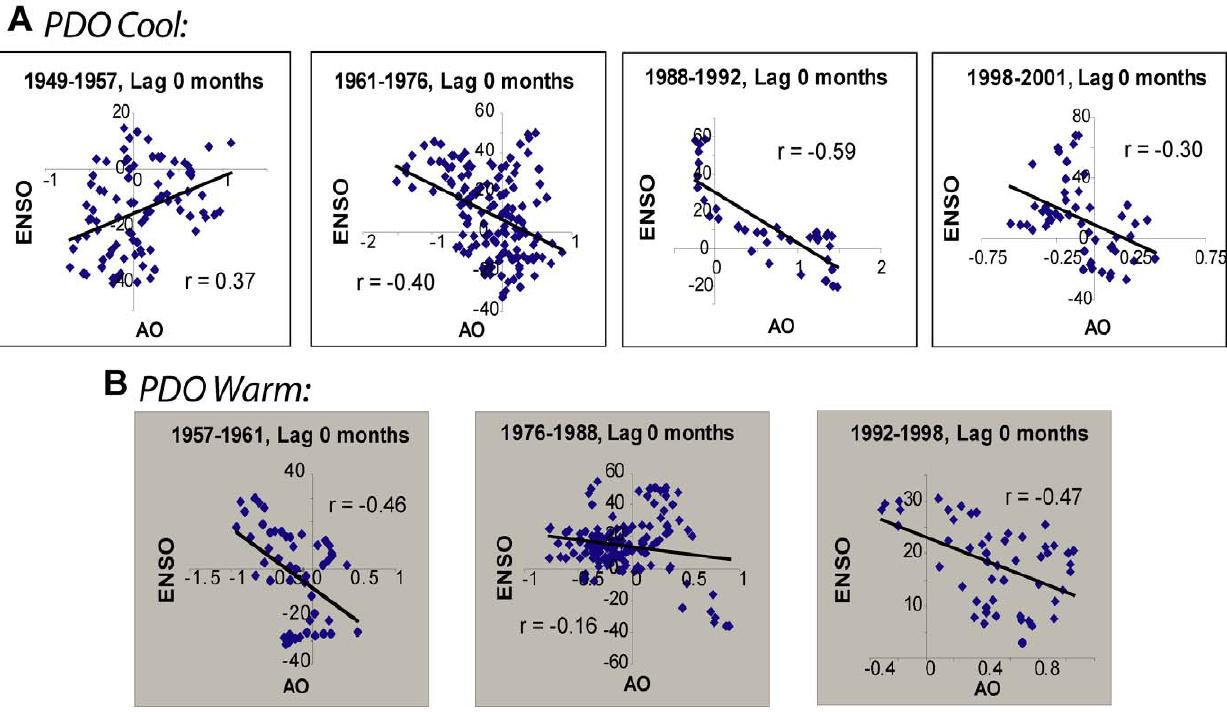
Figure 5. Plots of the Arctic Oscillation (AO) against Global-SST ENSO index across the history of the PDO index since 1946. Data were pre-whitened to reduce autocorrelation. Cross-correlation coefficients (displayed) were estimated for the entire periods indicated. Data are plotted at a lag of zero months, which maximized the cross-correlation coefficient magnitude in order to convey the strength of the relationship.